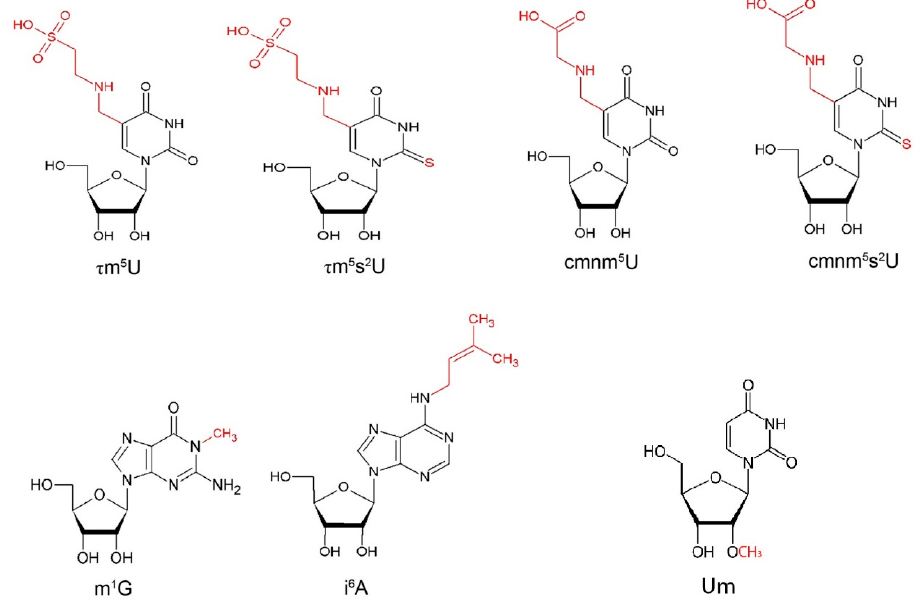
Figure 2. Modified nucleotides found in human and yeast mt-tRNAs and mt-rRNAs after the modifications catalyzed by the enzymes reported in Section 2. Modifications are highlighted in red. Abbreviations are as in Tables 1–4.